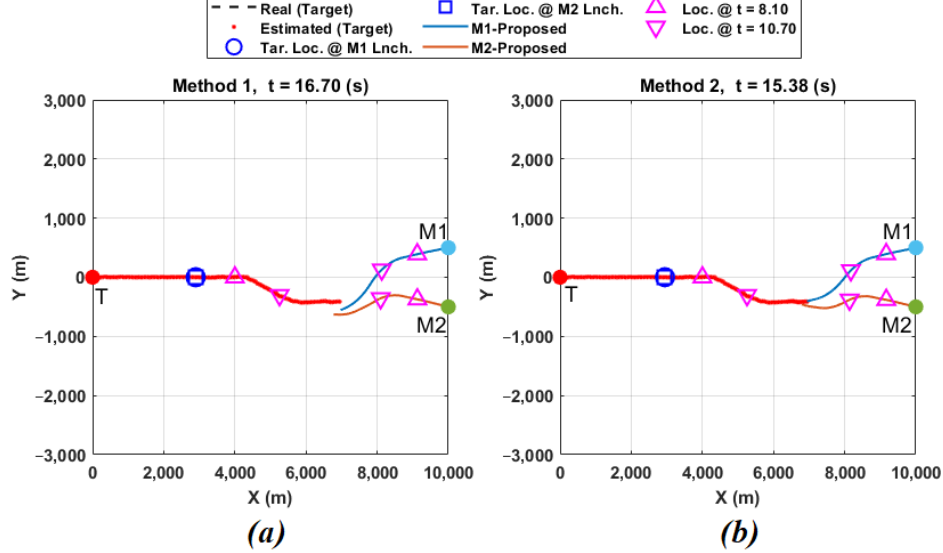
Figure 9. An example of trajectories where t α = 7, v 1 = v 2 = 400 m/s, MC Run No. 71. ( a ) Method 1, ( b ) Method 2.